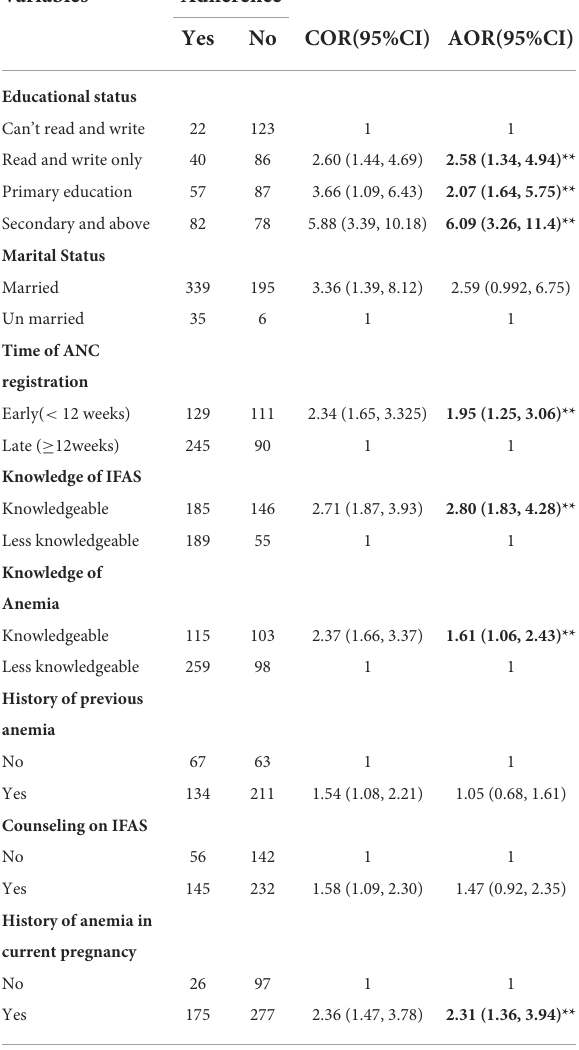
TABLE 2 Factors associated with adherence to IFAS among pregnant women attending ANC Clinics at Metema woreda governmental health institutions, North west Ethiopia, May 2021 ( N =